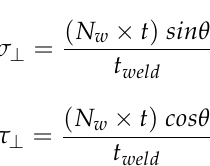
Figure 19. Stresses at the welded corner and the weld throat plane. ( a ) Reactions at the welded joint; ( b ) Reactions at the weld throat plane.